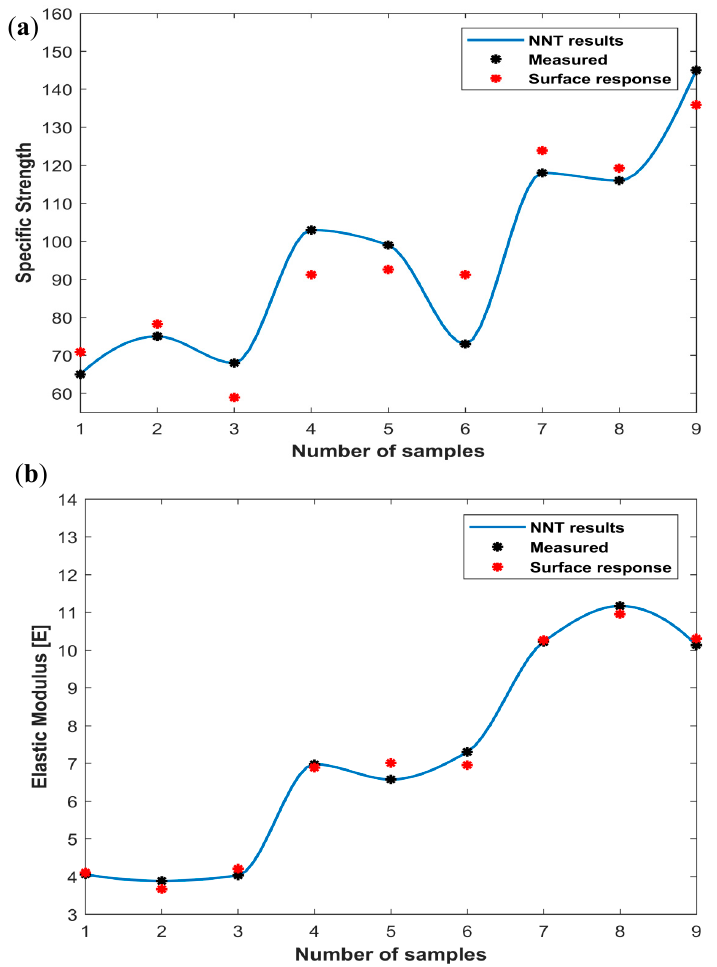
Figure 10. Measured results compared to the surface response and ANN models: ( a ) specific strength; and ( b ) elastic modulus.